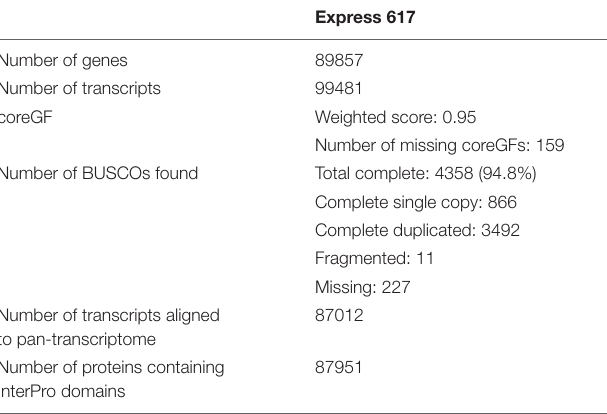
TABLE 2 | Gene annotation and evaluation of the Express 617 genome.